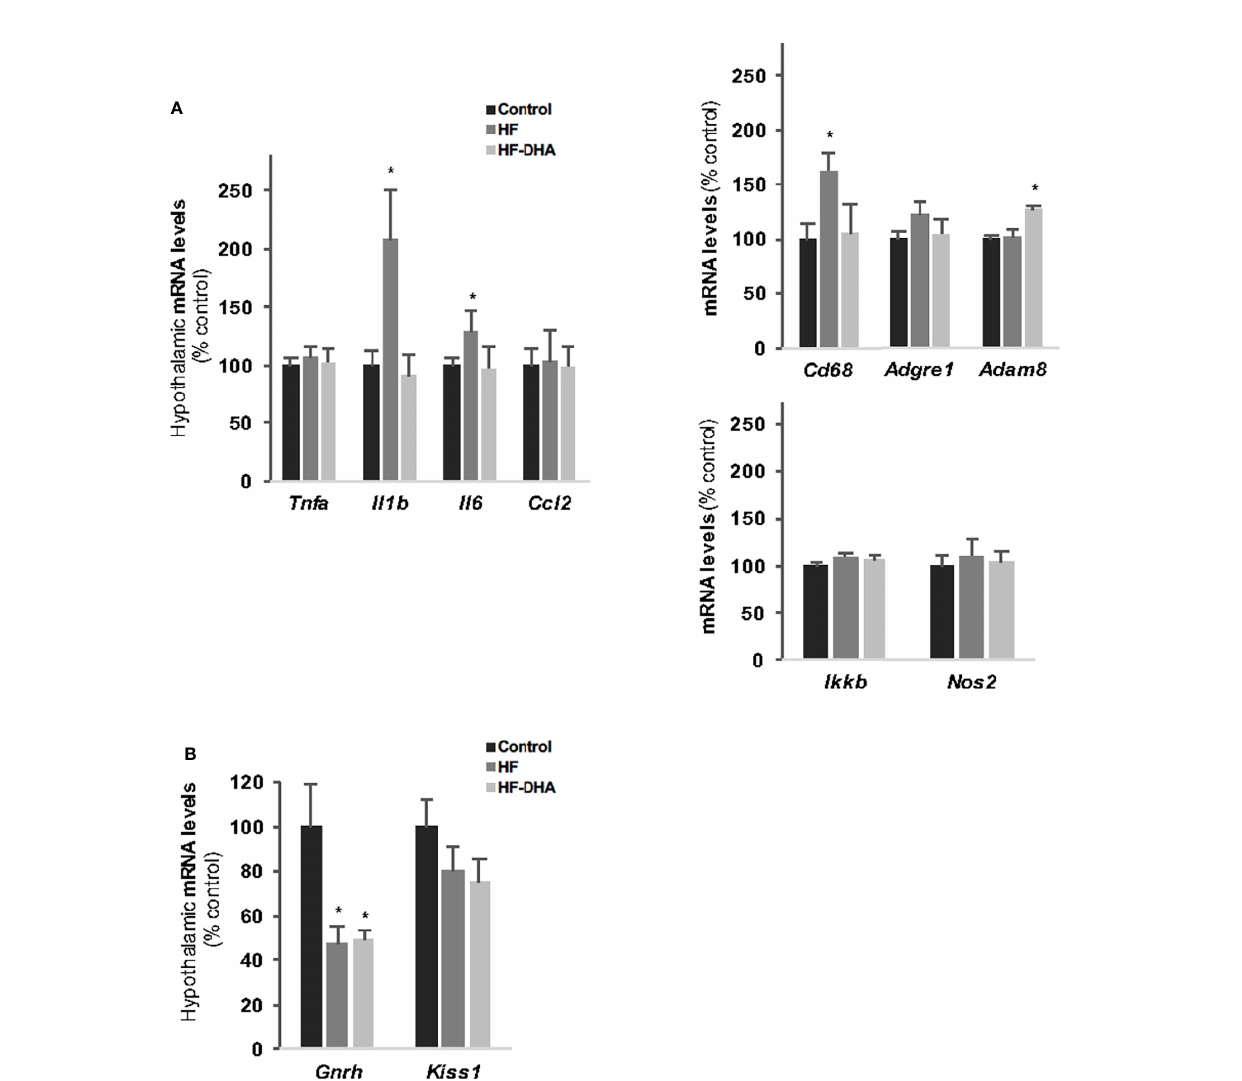
FIGURE 3 | Hypothalamic in fl ammation and levels of GnRH and Kiss-1 transcripts in rats after 4 weeks of high-fat diets. (A) Transcript levels of pro-in fl ammatory cytokines ( Tnfa , Il1b , Il6, Ccl2) , in fl ammatory-related ( Ikkb and Nos2 ) and macrophage ( Cd38 , Adgre1 , Adam8 ) genes in hypothalamus of rats fed control, HF or HF- DHA diets for 4 weeks. (B) Hypothalamic transcript levels of Gnrh and Kiss 1 in control and in rats fed short-term diet. Transcript levels were determined and expressed as indicated in Figure 2B . Data are means ± SEM (n= 6-8 rats) and were analyzed with Kruskal-Wallis test followed by Dunnett ’ s multiple comparison test. * P ≤ 0.05 vs control